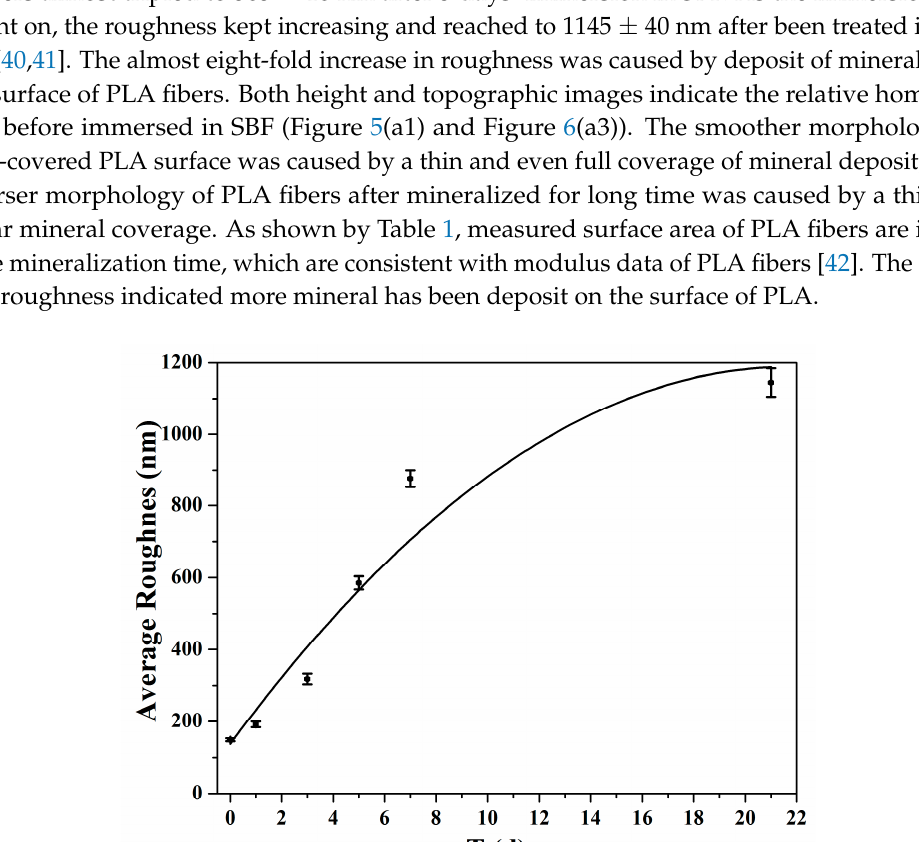
Figure 7. Average Roughness figure of PLA nano fibers with different mineralization time.